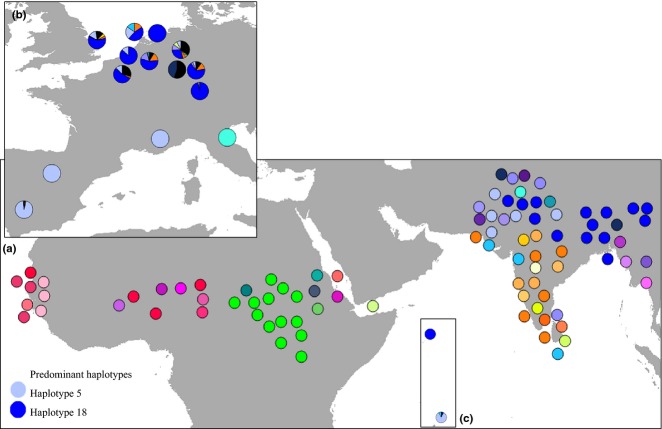
Distribution of 74 haplotypes across the native and invasive range of Psittacula krameri, based on 868 bp of mitochondrial DNA (mtDNA). (a) pie charts represent the approximate location of each museum specimen. Different colours relate to different haplotypes. (b and c) pie charts represent the frequency of native mtDNA haplotypes detected within each invasive population across Europe, Mauritius and Seychelles (for observed frequencies for each population, see Table S4, Supporting information). Black proportions indicate mtDNA haplotypes detected in invasive populations that were not detected in the native range. Locations of pie charts represent the approximate geographical location of the samples (exact coordinates/location details are given Table S2, Supporting information).